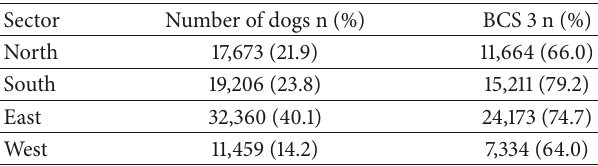
Table 1: Percentage of dog numbers according to the sector of the cityofSanFranciscodeCampecheandpercentageofdogswithgood body condition score (BCS 3).